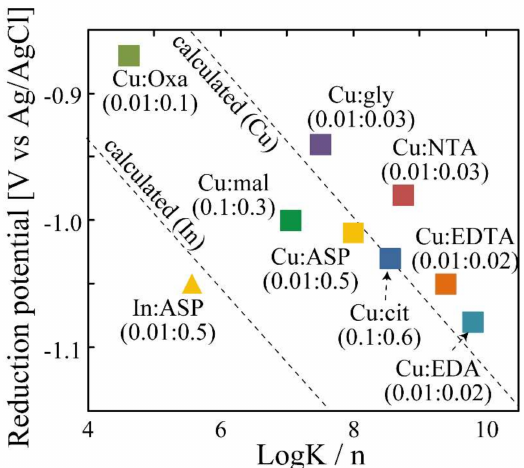
Figure 2. Relationship between LogK/n and reduction potential of homogenized Cu complexes. Reduction potential of Cu and In complexes calculated from Equations (8) and (9) were also inset in the figure (dotted